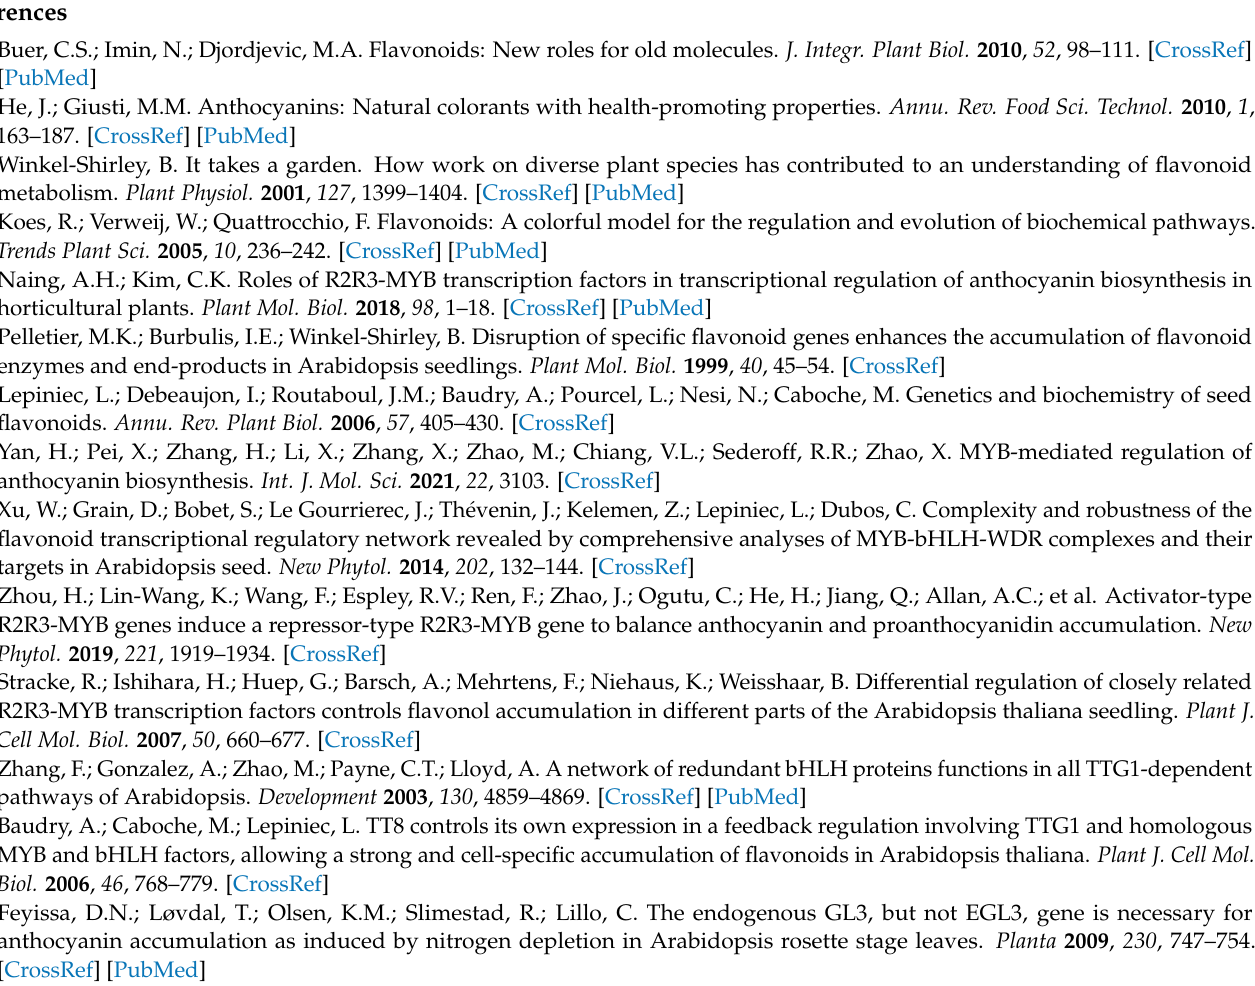
Figure S3: Expression pattern of structural genes under three different temperatures; Figure S4: Homology tree showing the similarity of TFs CDS cloned from 18M-245 with the homologous genes from Brassica A and B genome; Table S1: Primers used in this